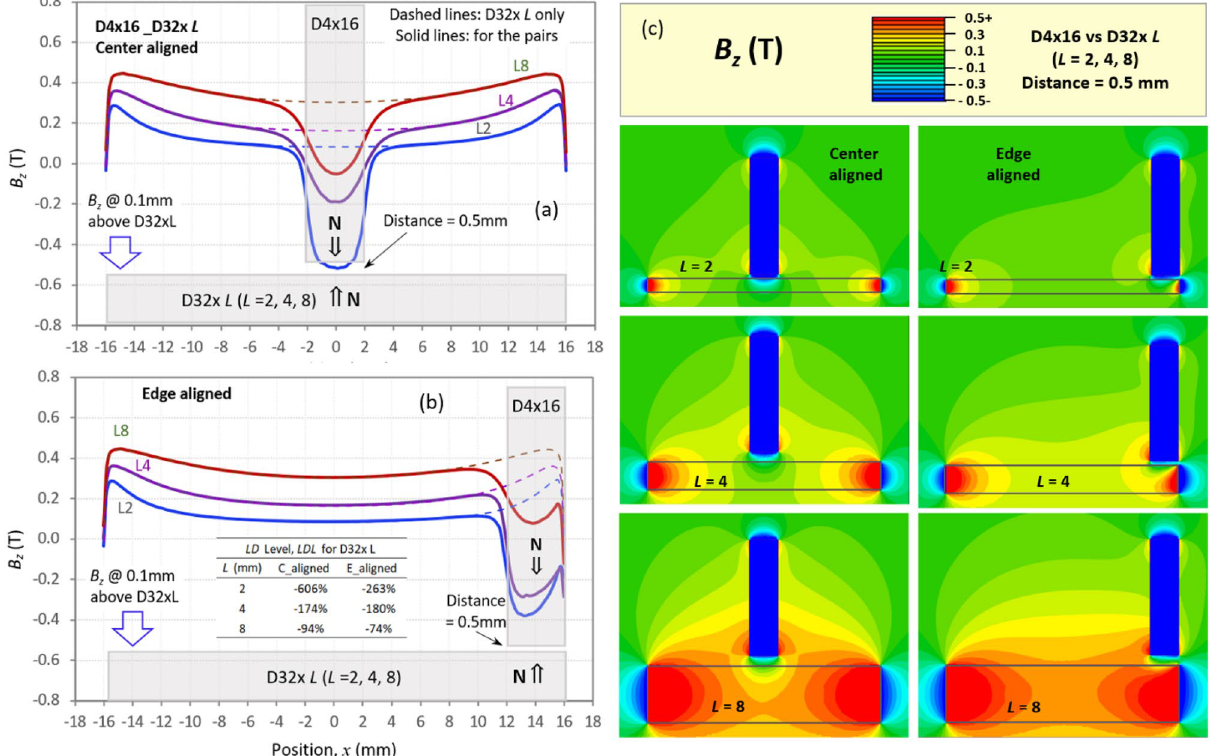
Figure 5. The B z distributions show the LDL and the EE of three N55 pairs of D4 × 16 vs. D32xL like poles in Series #2 for the center-aligned ( a ) and edge-aligned ( b ). The LDL values of D32xL are listed in the inset of ( b ), which were calculated by using Eq. (1). The details for this individual case are shown here: x 2 (cid:31) x 2 x 1 B z _D32x L + D4x16 dx − (cid:31) x 2 x 1 B z _D32x L dx x 1 B z _D32x L + D4x16 dx LDL = (cid:31) (cid:31) = , where B z _D32x L + D4x16 is the B z of D32x L paired (cid:31) x 2 x 1 B z _D32x L dx (cid:31) x 2 x 1 B z _D32x L dx with D4 × 16, and B z _D32xL is the B z of the standalone D32x L . The x 1 and x 2 are the positions enclosing the LD effect regions beneath D4 × 16. In the table, the column headers “C_aligned” and “E_aligned” stand for center-aligned and edge-aligned, respectively. Plots are given for the center-aligned pairs x 1 = − 2mm and x x x 2 = 2mm ( a ) and for the edge aligned pairs 1 = 12mm and 2 = 16mm ( b ). The 2D B z maps at the cross- sections through diameters of the center- and edge-aligned three pairs are shown in ( c pairs, | LDL | is 32.7% at d = 10 mm and 9.6% at d = 18 mm. When near the TP , | LDL | is 83.1% at d = 5 mm. At d = 0.2 mm, | LDL | is as large as 243%. The | LDL | of the center-aligned poles is higher than that of the edge-aligned poles, and the ratios of | LDL | center /| LDL | edge range from 1.43 to 1.92 in the distances of 0.2 to 18 mm. This is in good agreement with the difference in the force vs. distance behaviors between the center- and edge-aligned pairs, as shown in Figs. 1, 2 and 3, where the force on the center-aligned Series #1 N55 pairs and some N48SH pairs transforms from repul- sive to attractive with sufficiently small distances, while the force on the edge-aligned pairs remains repulsive in the same distance range. The 2D B z maps at the cross-section through a diameter for both center- and edge-aligned like poles with distances d = 0.2 and 50 mm are displayed in Fig. 4(d), showing the LD effect and edge effect ( EE , i.e. higher B z fluxes near the edges). The curves of B z vs. x at the distances below D16 × 2 are also affected by D32 × 2, but the B z near D16 × 2 remains negative without changing the polarity of D16 × 2 since it has a higher P c . The B z distributions of three pairs of Series #2 N55 like poles are shown in Fig. 5, which have the same dimen- sions as three of the four shown in Fig. 1(d); these are D4 × 16 vs. D32x L ( L = 2, 4, and 8 mm), with P c ratios of 185, 85.7, and 39.3 and a fixed distance of 0.5 mm. The B z is calculated along a line 0.1 mm above a diameter of D32x L . Figure 5(a) and (b) show the B z of center- and edge-aligned pairs, respectively. The B z curves of the standalone D32x L are displayed in the figures as dashed lines. The LDL values are listed in the inset of Fig. 5(b), which were calculated by using Eq. (1). The calculation details for this individual case are shown in the caption of Fig. 5. The | LDL | values of the center- and edge-aligned are close to each other for D32 × 4 and D32 × 8, which are in good agreement with the similarity of the force vs. distance behaviors between the two alignment conditions, as shown in Fig. 1(d). The | LDL | values for D32 × 2, on the contrary, are substantially different between the center- and edge-aligned (606 vs. 263%, respectively), showing a much stronger LD effect in the center-aligned than in the edge-aligned. The remarkable difference in | LDL |, however, does not lead to a distinct difference in their force vs. distance behaviors. This is thought to be because the LD effect on the force saturates when | LDL |> 260%.